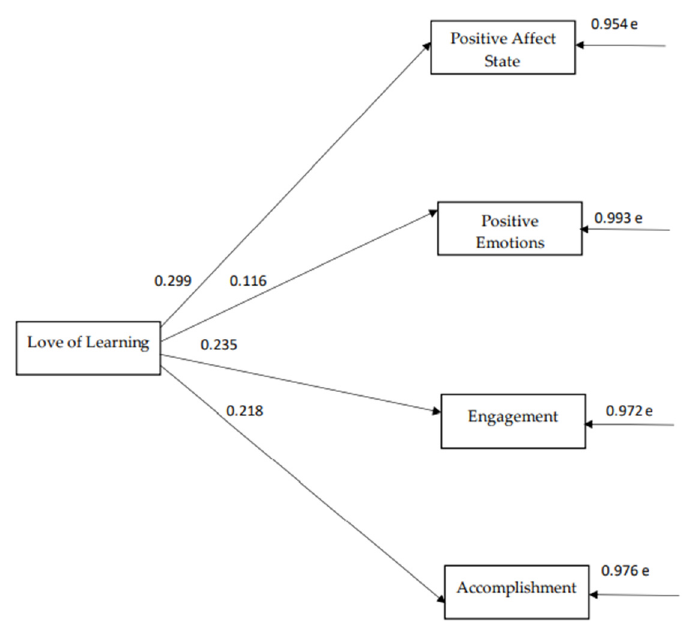
Figure 6. The relationships between virtue of knowledge dimensions and subjective wellbeing components.